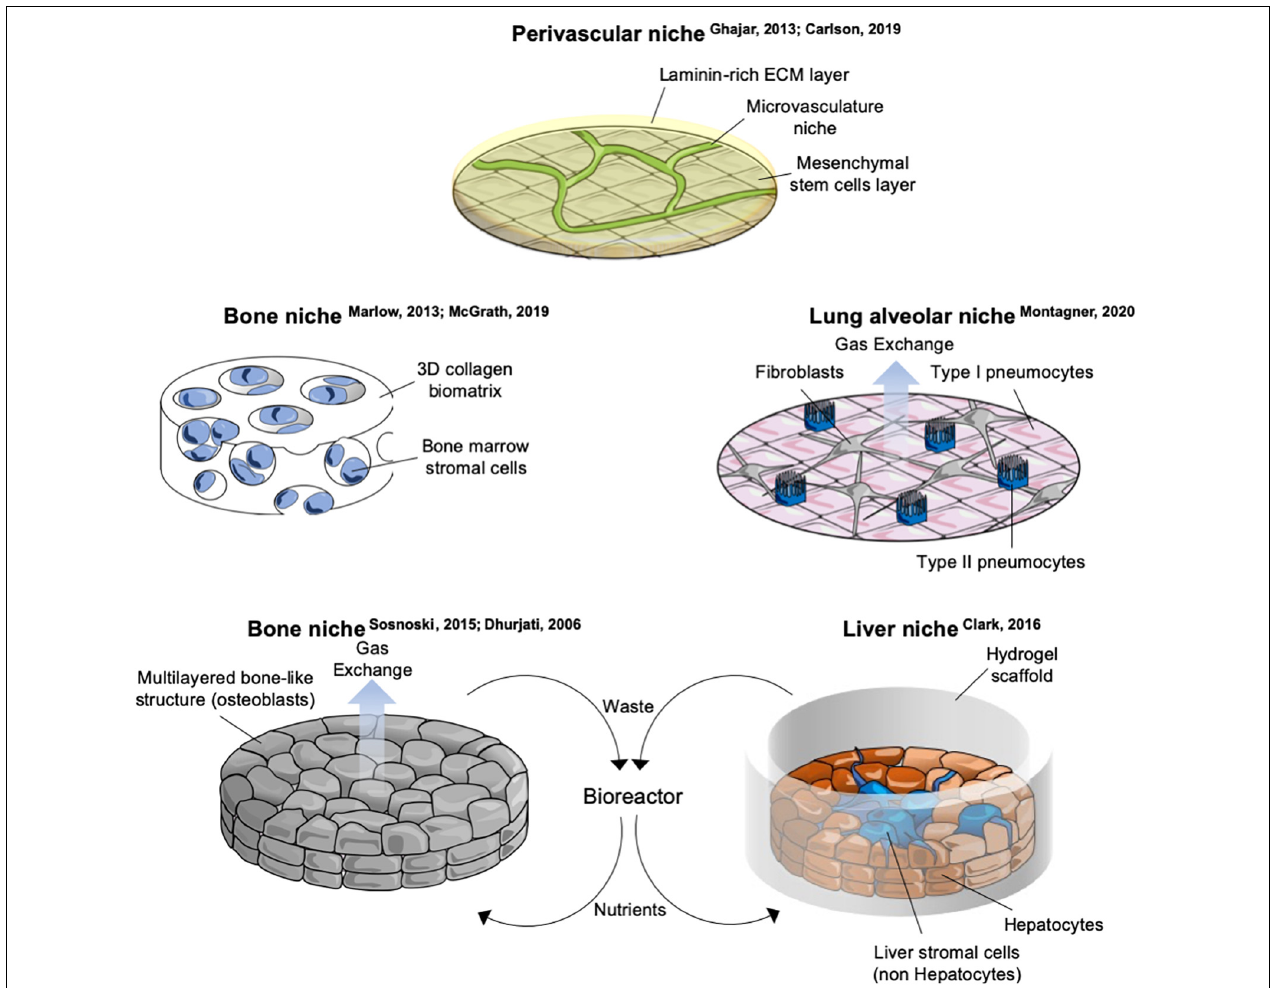
FIGURE 2 | Schematics of selected in vitro organotypic systems designed for studying breast cancer cells (BCCs) metastatic dormancy. Schemes of in vitro systems developed to mimic microenvironments of specific metastatic organs. Details and references of each system are provided in Supplementary Table S2 .